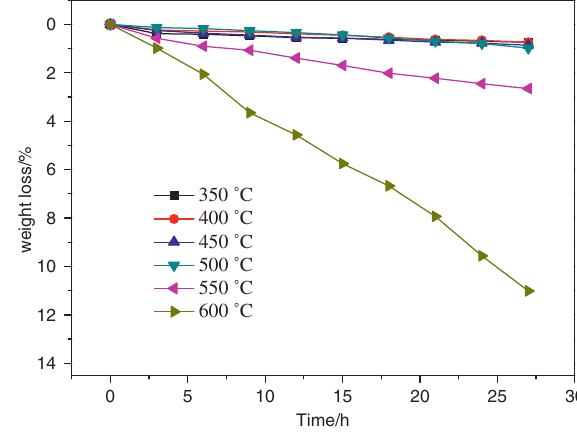
Figure 6: Weight loss vs time of purified Solar Salt at different